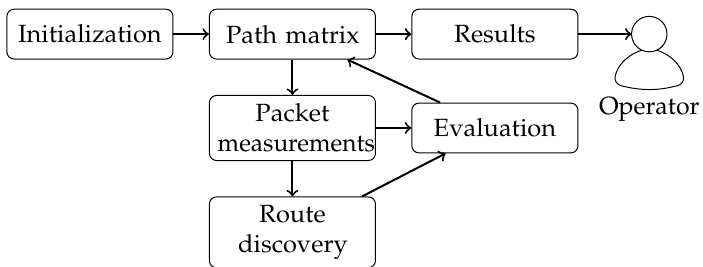
Figure 8. Concept of failure localization